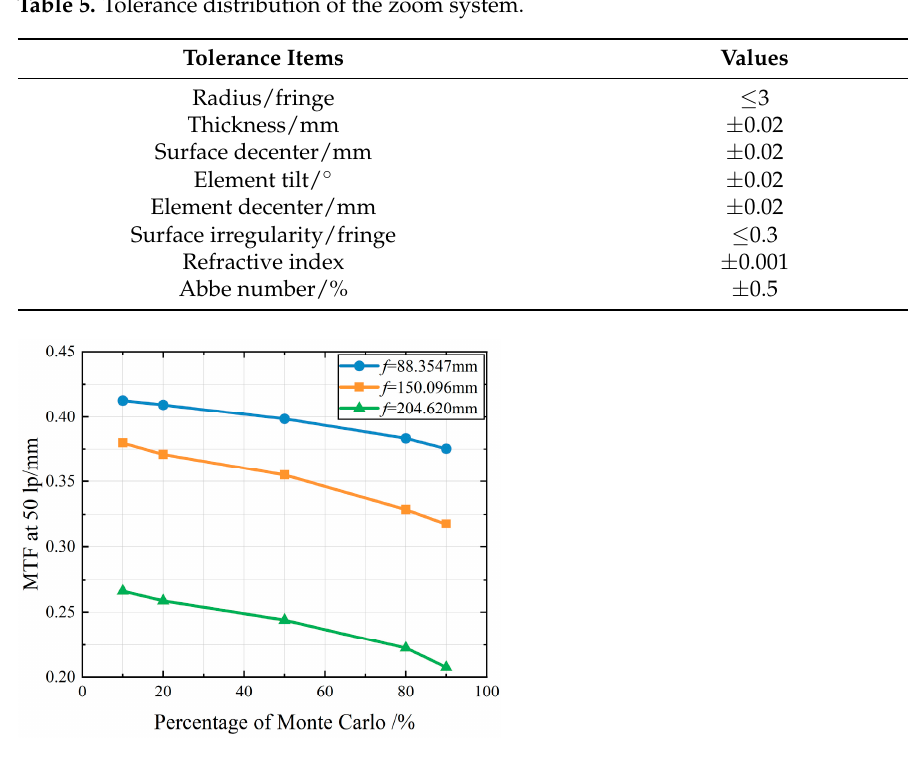
Figure 12. Zoom curves.